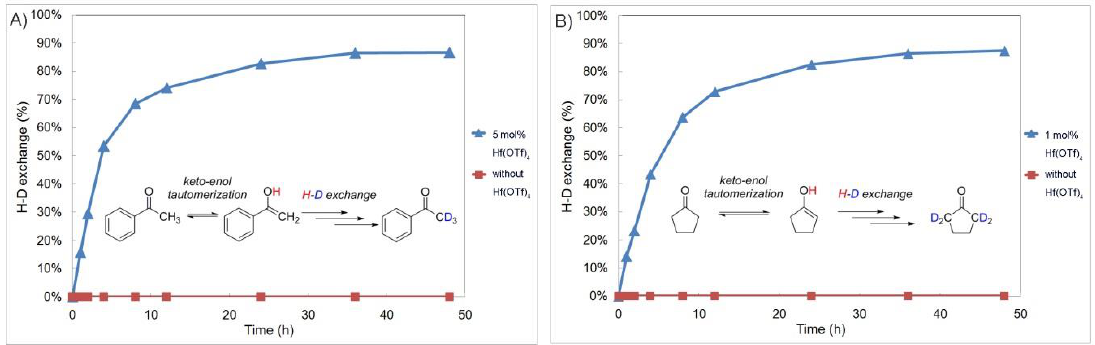
Figure 1. The H / D exchange reactions of acetophenone ( A ) and cyclopentanone ( B ) in MeOH- d 4 in the absence or presence of Hf(OTf) 4 .